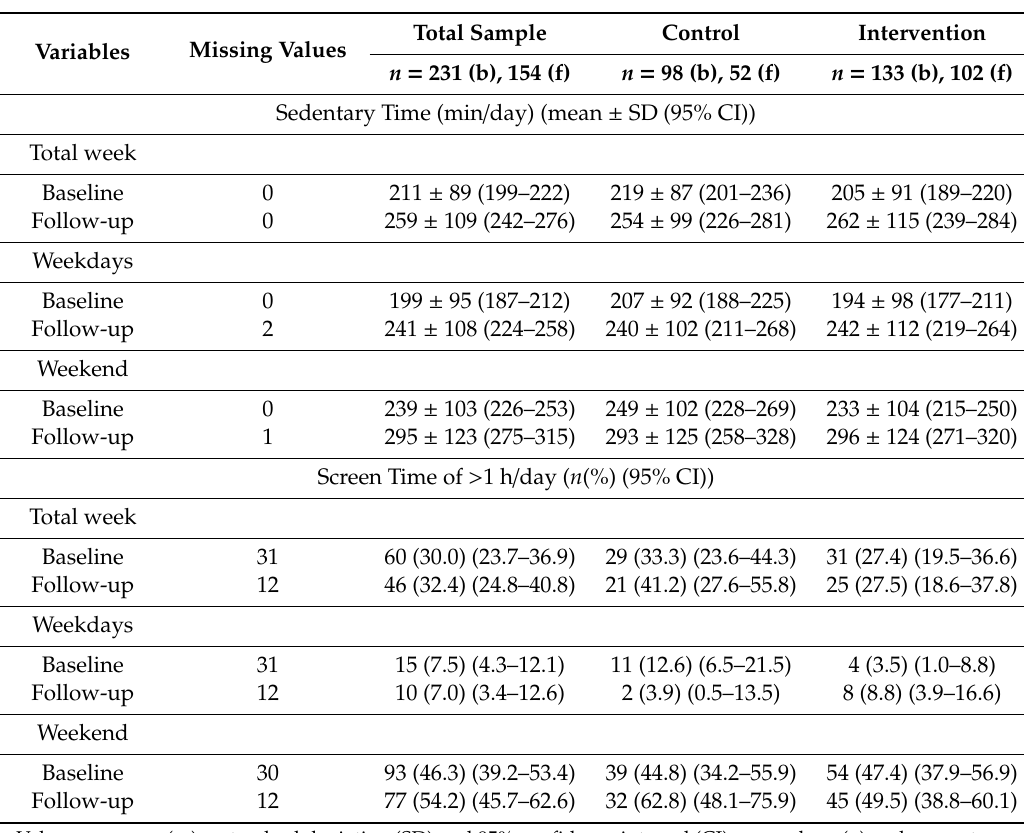
Table 2. Time at baseline and follow-up (in rounded min) spent in sedentary time (without sleep) and percentage of children using screen media for more than one hour per